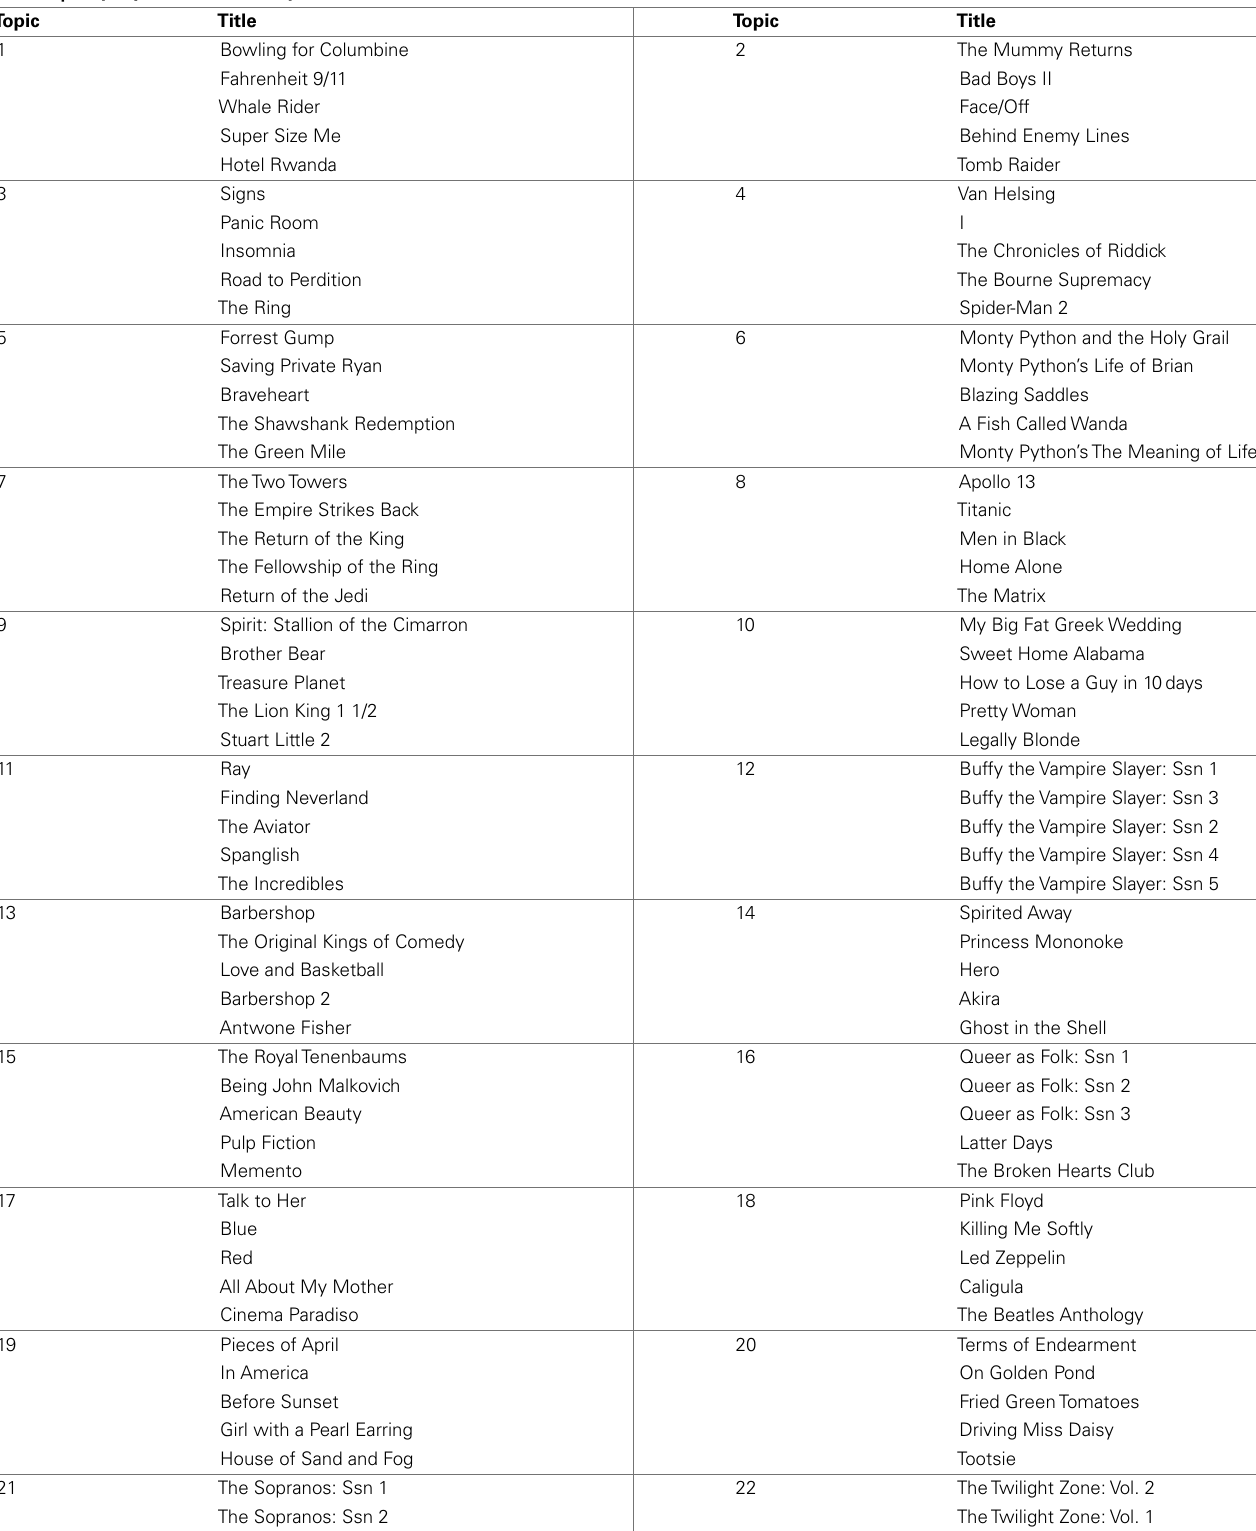
Table 2 | Fifty topics from likability